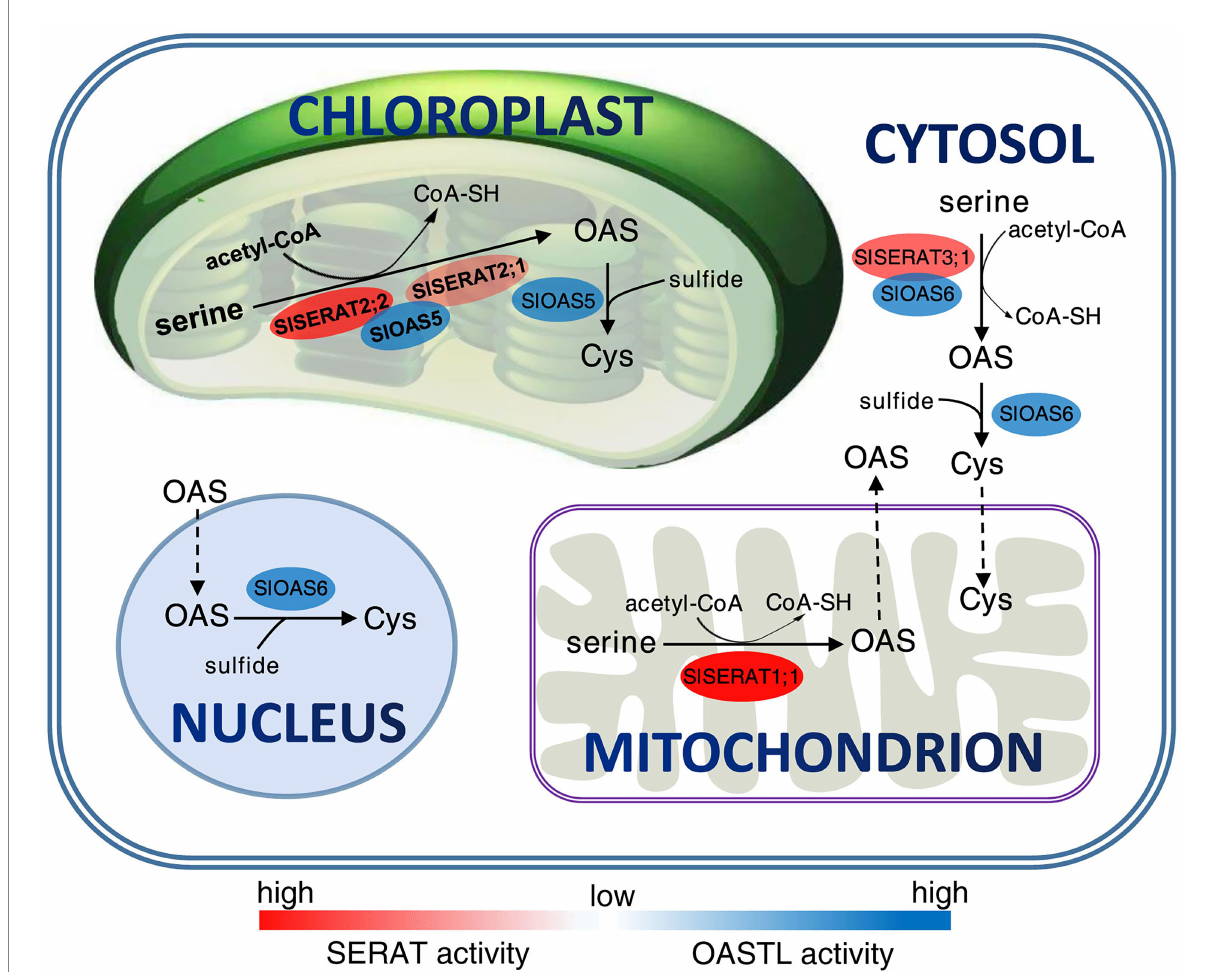
FIGURE 8 Main pathways surrounding the production and transport of the cysteine (Cys) and O-acetylserine (OAS) within a tomato cell. The SERAT proteins are red-colored, and the OASTL proteins are blue-colored. The color strength behind each enzyme indicates their relative activity detected in vitro . The dotted arrows show the predicted transport routes of Cys and OAS in a tomato cell based on the evidences obtained from the slsearat1;1 mutants and the nucleus localization of